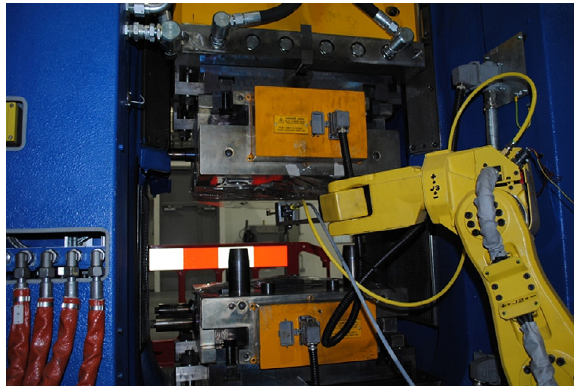
Figure 13. Robot operating inside press